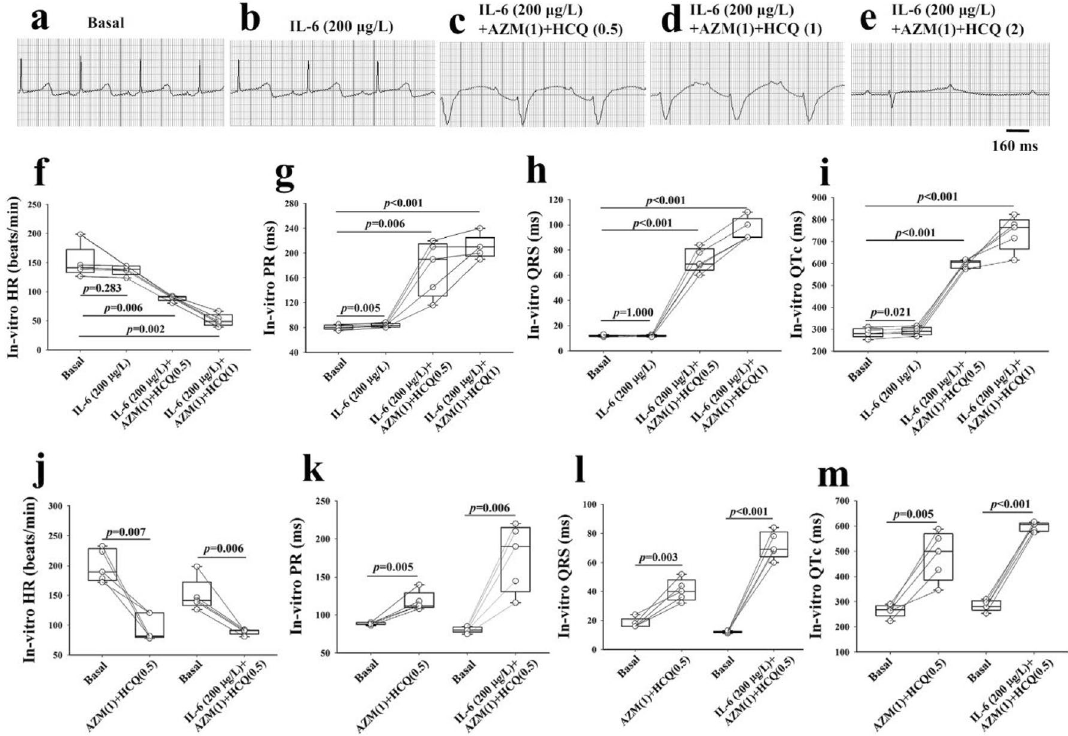
Figure 4. In-vitro impact of interleukin-6, azithromycin and hydroxychloroquine on the electrogram of Langendorff perfused guinea pig hearts. Electrograms of an isolated guinea pig heart before ( a ) and ( b ) after perfusions of IL-6 (200 μg/L) alone for 40 min, ( c ) IL-6 + AZM(1) + HCQ(0.5), ( d ) IL-6 + AZM(1) + HCQ(1) and ( e ) IL-6 + AZM (1) + HCQ (2). The comparison of individual data points for heart rate (HR), PR, QRS and QTc between baseline and the different interventions is illustrated in panels ( f–i) using paired t-test. Heart rate ( j ), PR ( k ), QRS ( l ) and QTc ( m ) data from two groups of guinea pigs, one (n = 5) perfused with AZM(1) and HCQ(0.5) and the other (n = 5) perfused with IL-6(200 µg/L) + AZM(1) + HCQ(0.5). AZM(1) = 41.5 mg/L; HCQ(0.5) = 24.9 mg/L. AZM(1) = 41.5 mg/L; HCQ(0.5) = 24.9 mg/L; HCQ(1) = 49.8 mg/L; HCQ(2) = 99.6 mg/L. Paired t-test was used to compare interventions to baseline. (*) indicates p < 0.05.